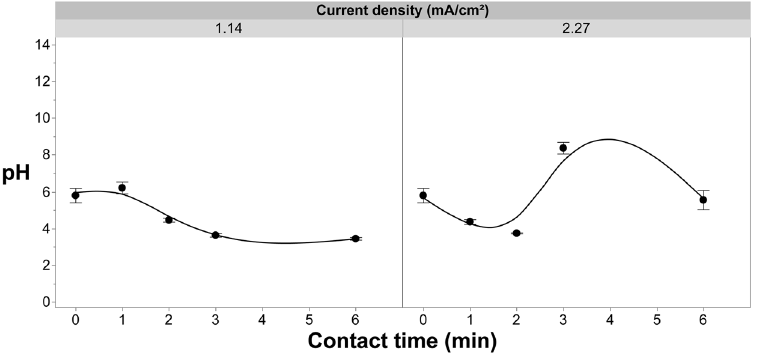
Figure 16. The pH of the solution as a function of current density (1.14 & 2.27 mA/cm 2 ) and contact time of the solution containing (NH 4 ) 2 SO 4 as the supporting electrolyte (relative to 0.05 g/L of 20-8-20 Plant Prod fertilizer) and 20 mg/L of chloride. Error bars are ± SEM, N =